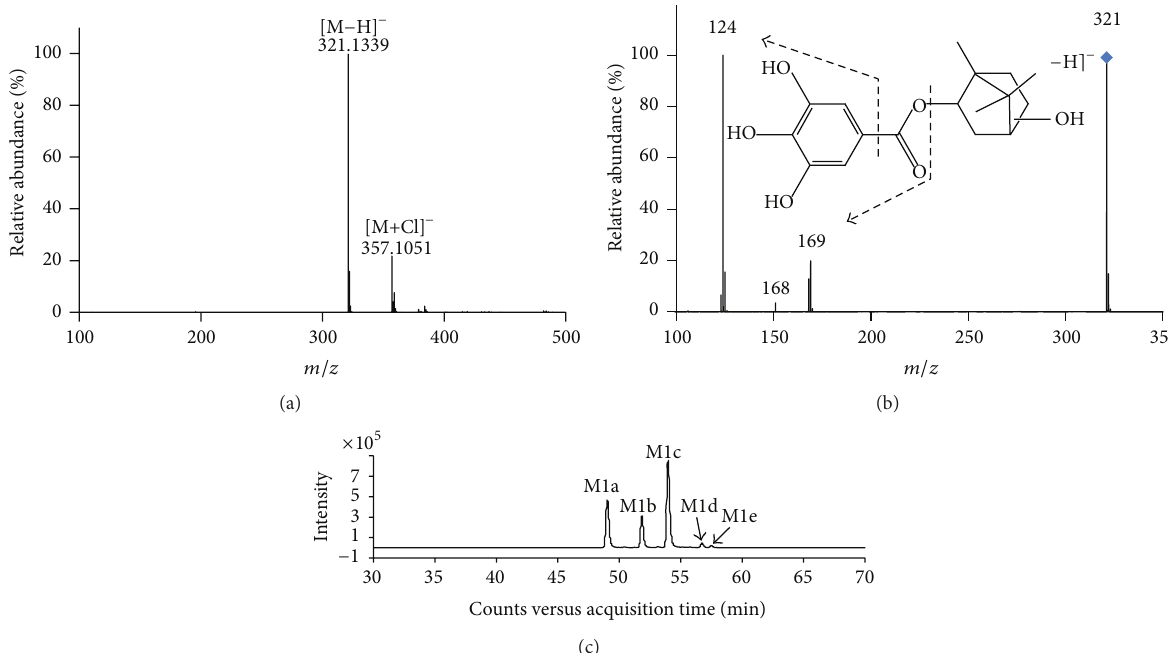
Figure 3: Representative MS, MS/MS spectrum, and extracted ion chromatogram (EIC) of in vitro metabolites of BG in rat liver microsomes (RLM). Incubations were performed at 37 ∘ C for 30 min in a system containing 3.06 mg/L BG and 0.5 mg/mL liver microsomal protein in 0.5 mL of 0.1mol/L phosphate buffer (pH 7.4). (a) MS spectrum; (b) MS/MS spectrum and the predominant fragmentation pattern of M1a are shown as the representative spectra of five metabolites, which exhibited almost identical spectra; (c) EIC of m/z 321.1339 representing 5 isomers of in vitro metabolites with their RTs at 49.0, 51.8, 54.0, 56.8, and 57.5min, respectively.